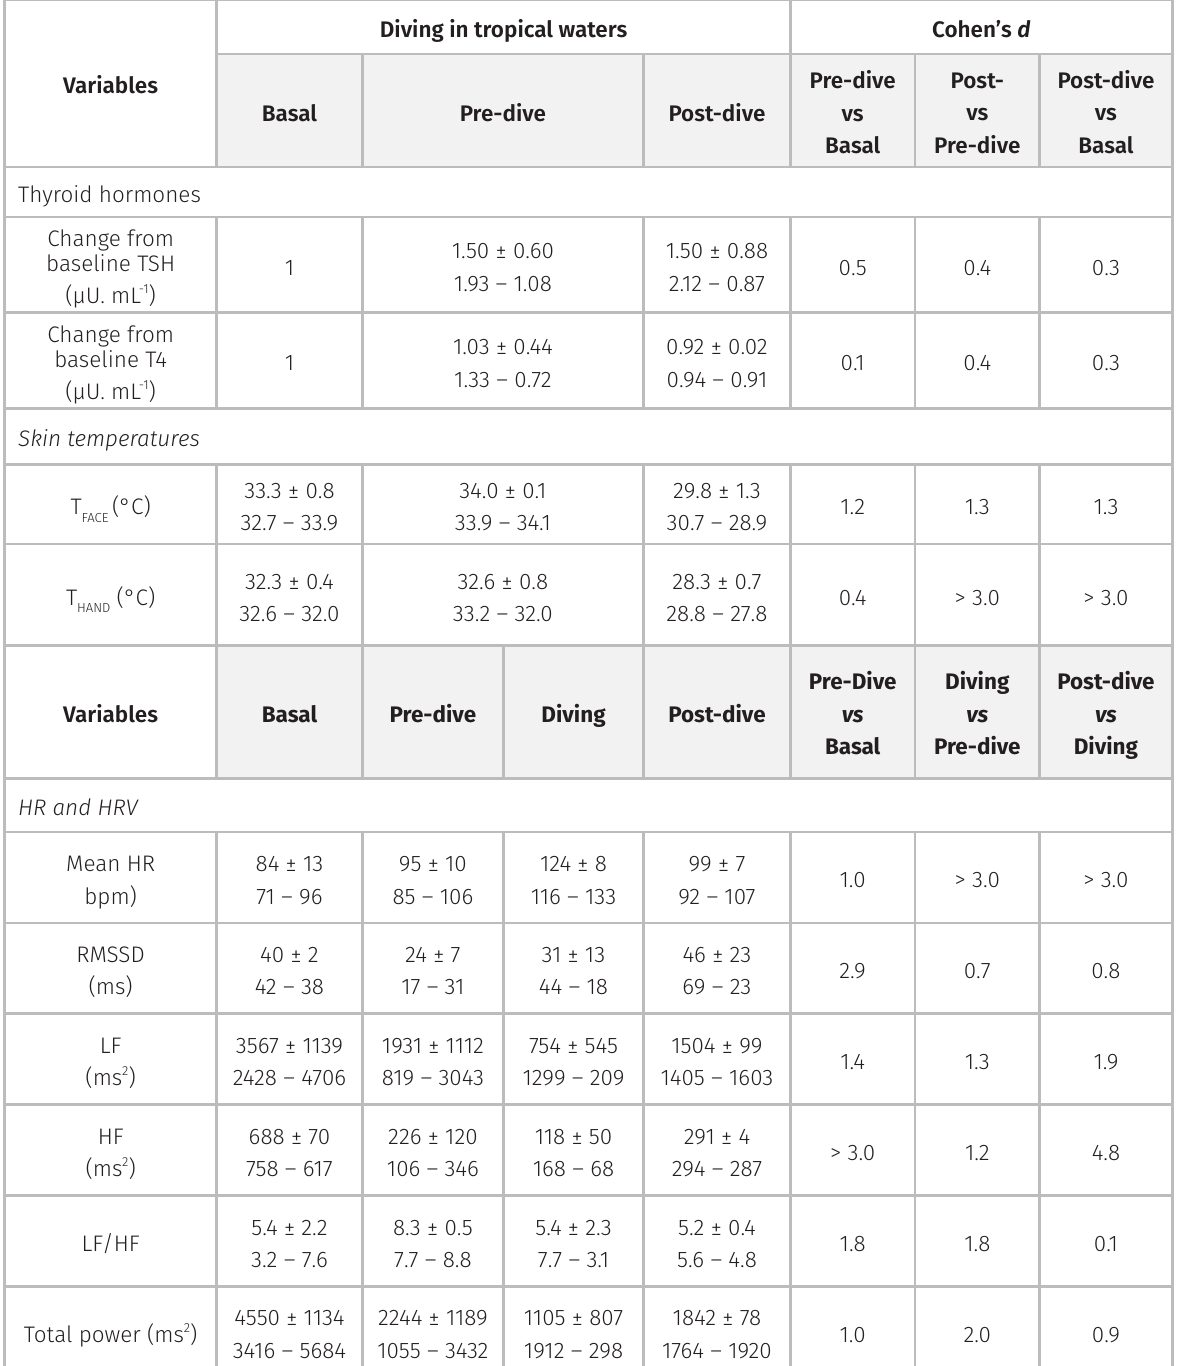
Table II. Psychophysiological changes induced by diving in tropical waters (Rio de Janeiro, Brazil).